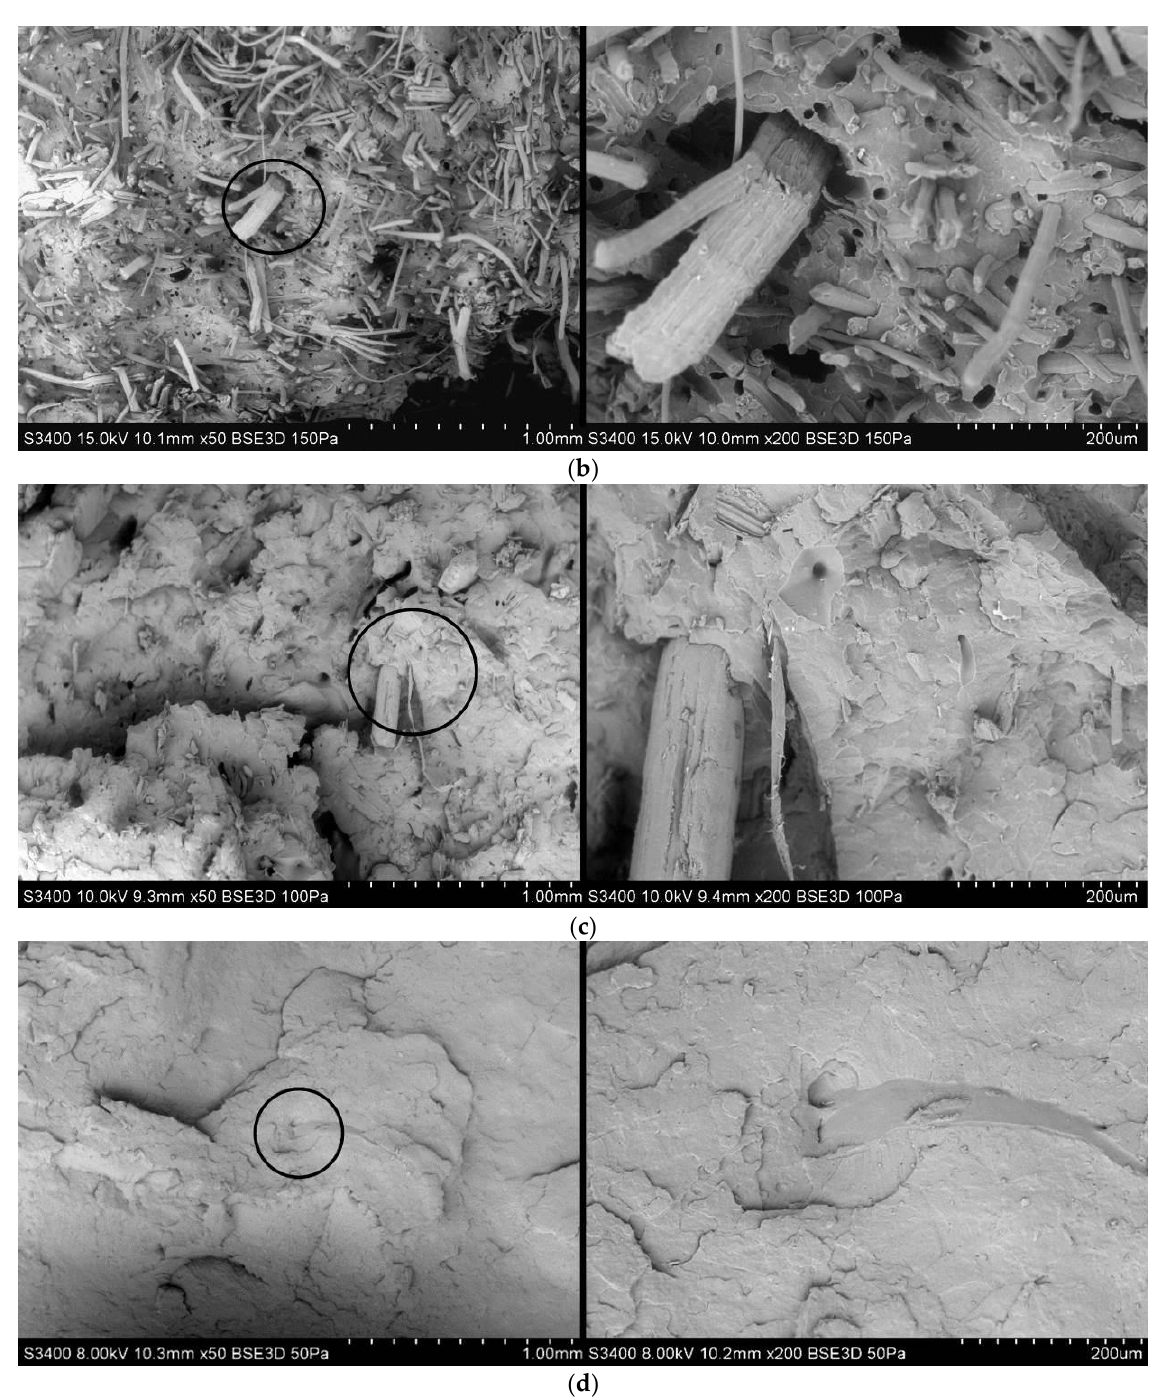
Figure 10. SEM photographs of fractures for biocomposites samples filled with fibers of ( a ) hemp, ( b ) flax and ( c ) wood; ( d ) SEM photograph for pure PHBV .